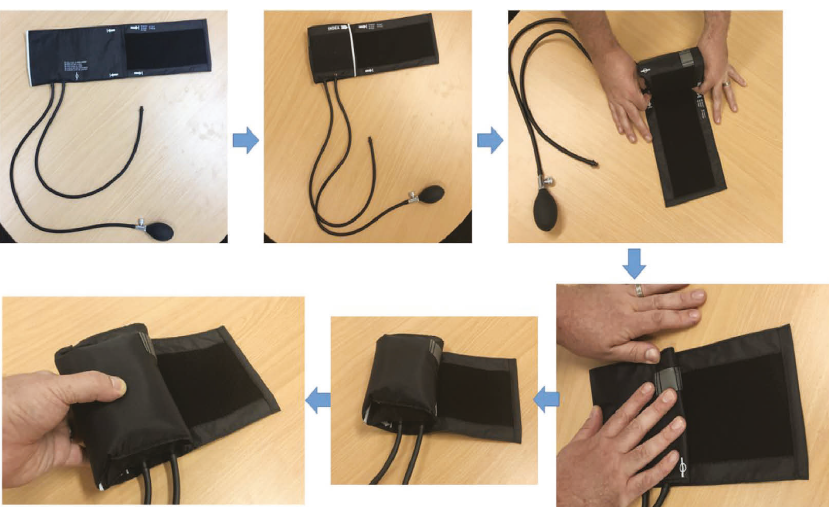
Figure 1: Creation of the blood pressure cuff for grip strength testing. The sphygmomanometer starts fully open, then, rolled closed to its minimum size on the fastening surface, then, inflated to 20 mm · Hg, resulting in a hand-sized